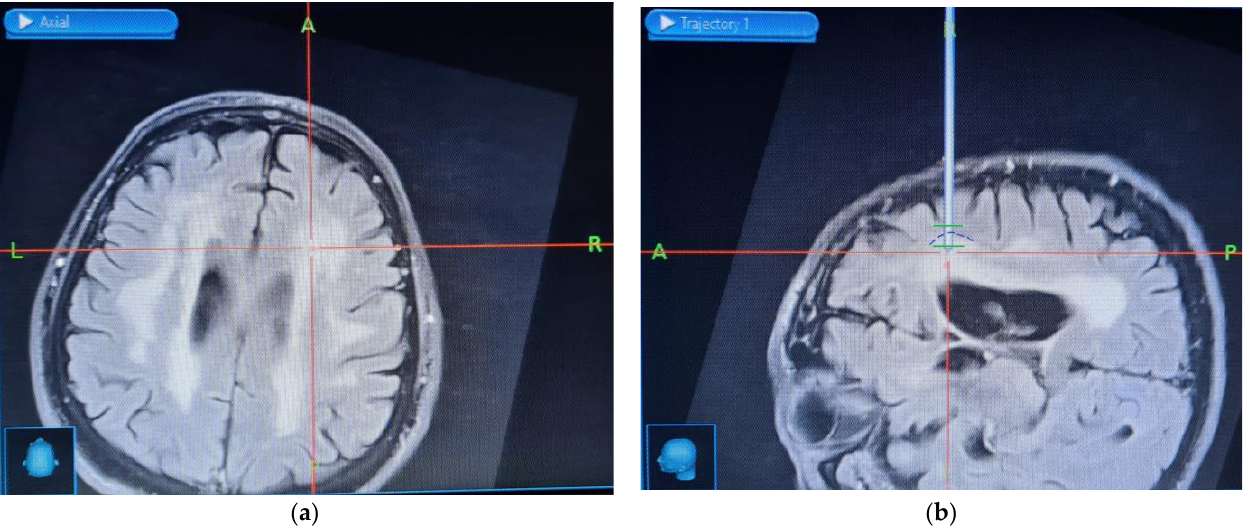
Figure 5. Stereotactic neuronavigation images: ( a ) the suspected area of brain tissue inflammation. The axes cross in the spot from which the sample was taken within the right frontal lobe; ( b ) the image of the border area between a healthy tissue and the lesions (the border is marked with a dashed blue line). The borders of the biopsy frame are marked in green.